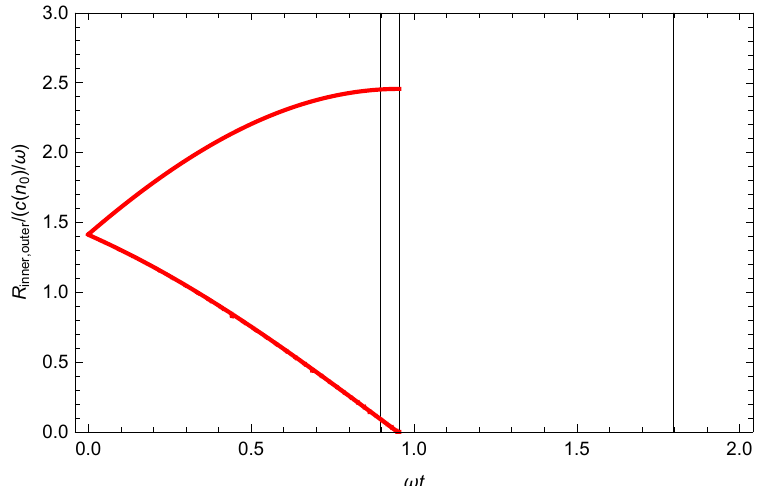
Figure 1: Numerically computed trajectories of the outer (upper curve) and inner (lower curve) edges of the shock wave front, together with the analytical predictions (29) and (35). The numerical curves are indistinct from the analytical predictions. The three thin vertical lines correspond to the following instants of time, in order from left to right: the experimentally observed half quasi-breathing period T / 7 (see [ 1 ] ), the hydrodynamic prediction for a half quasi-breathing period (30), and the full experimental quasi-breathing period 2 T / 7 observed in [ 1 ] . As we show below (see e.g. Fig. 2), at the instant of time t ∗ from (30), the density distribution develops a conical singularity at the origin, and so the hydrodynamical equations can not be propagated past this moment in